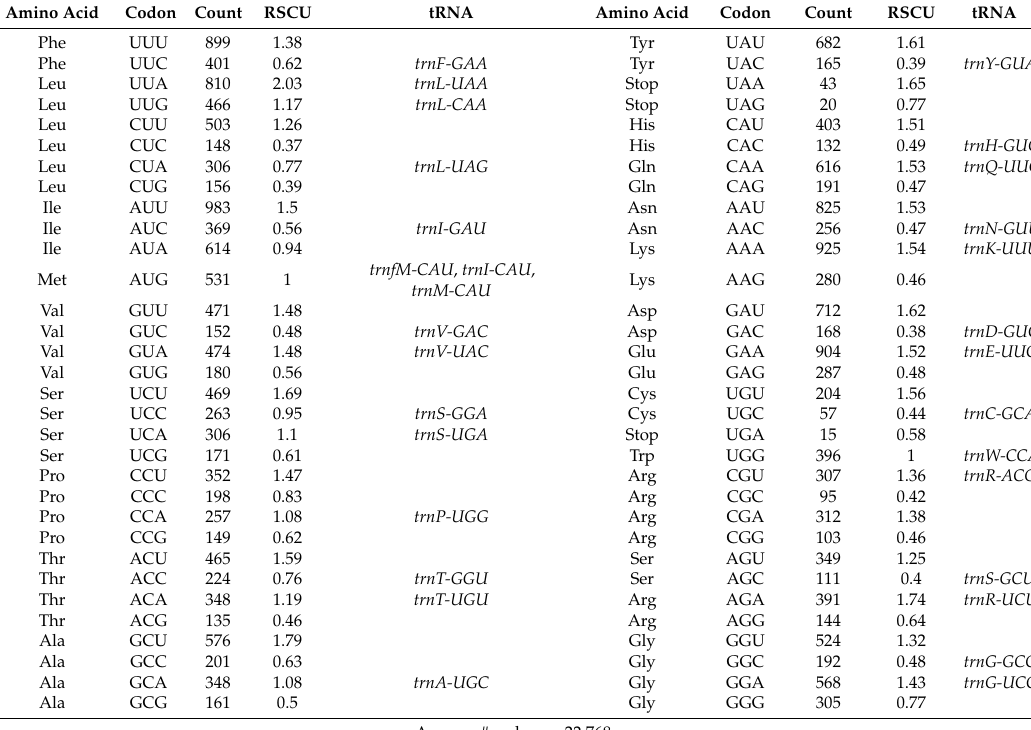
Table 4. Codon usage in the Sanguisorba officinalis chloroplast genomes. RSCU: Relative Synonymous Codon